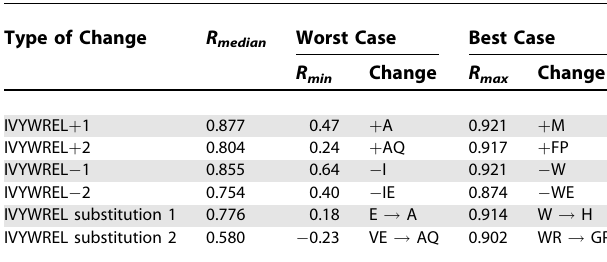
Table 1. Effects of the Changes in the IVYWREL